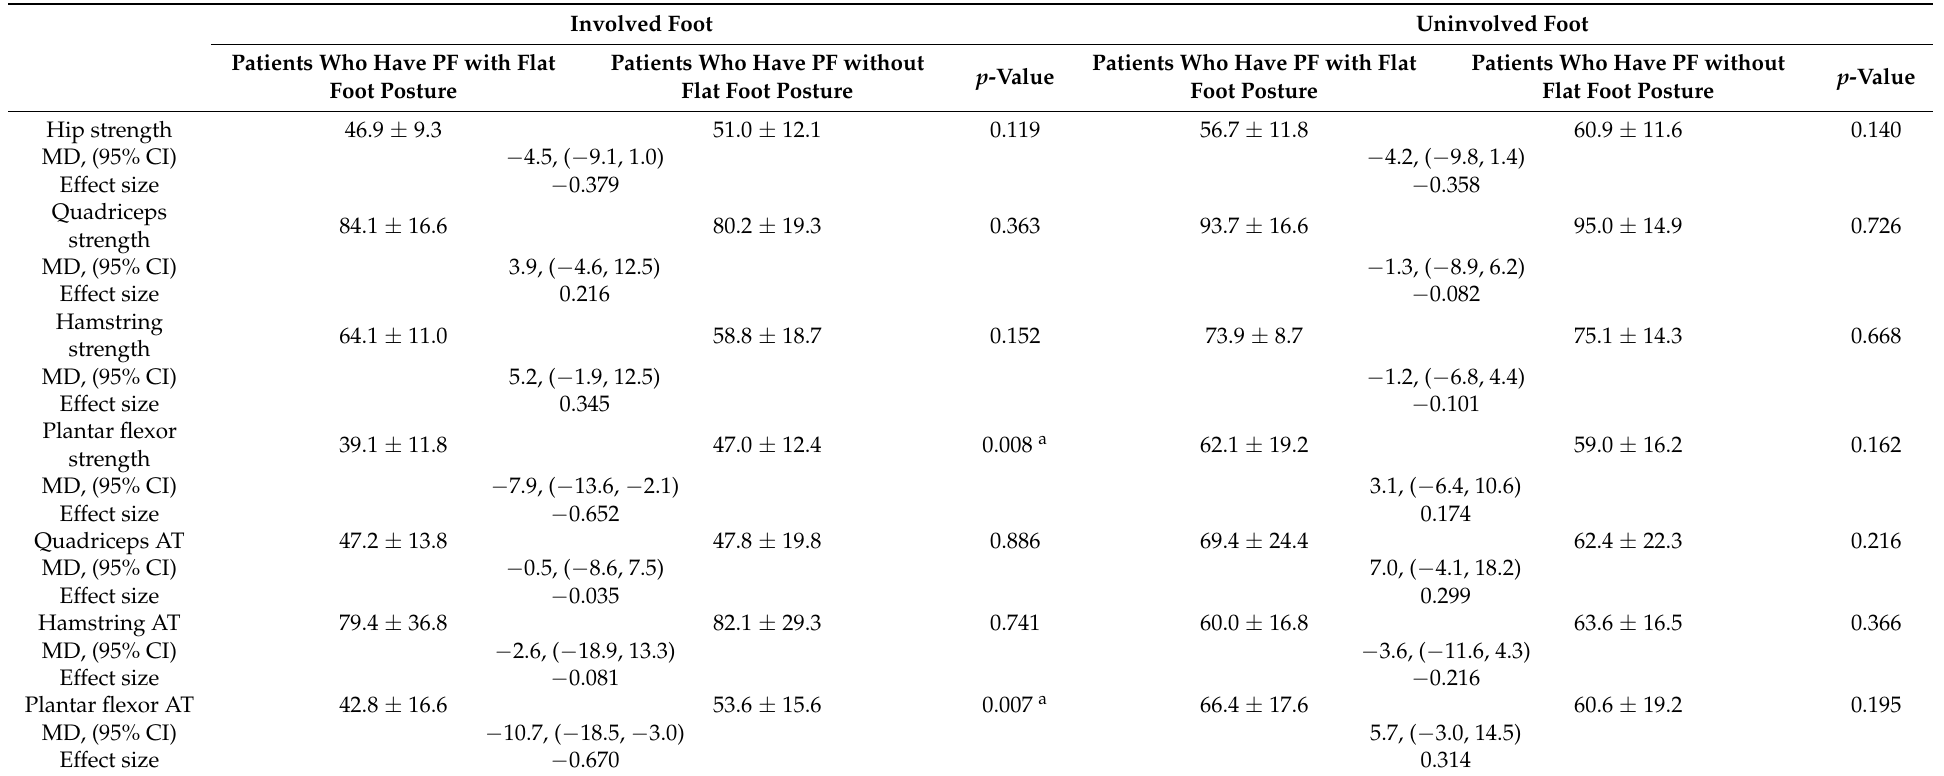
Table 2. Comparison of muscle strength and AT in both ankles of patients who have PF with and without flat foot posture. Involved Foot Uninvolved Foot Patients Who Have PF with